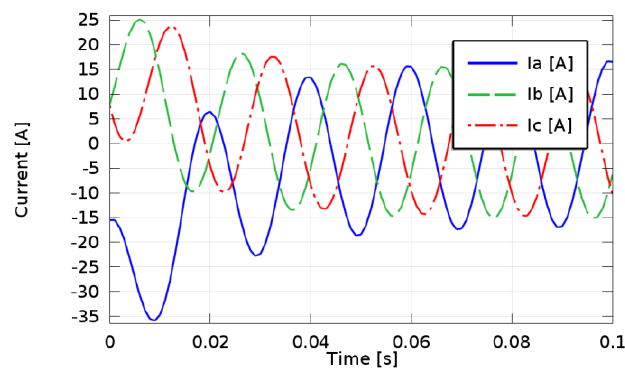
Fig. 10. The resulting phase